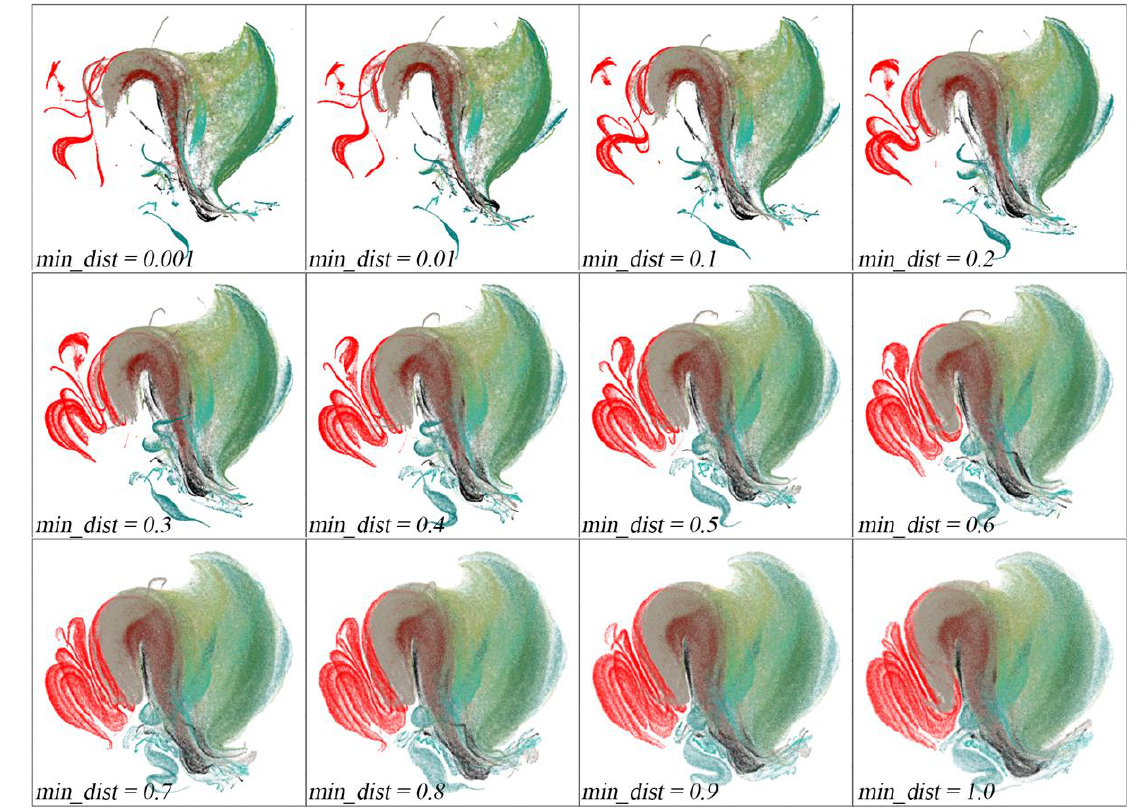
Figure A2. UMAP dependence on min_dist parameter. UMAP results for the image mosaic are shown for a range of min_dist parameter settings. All runs use 30 nearest neighbors and Euclidean distance metric.